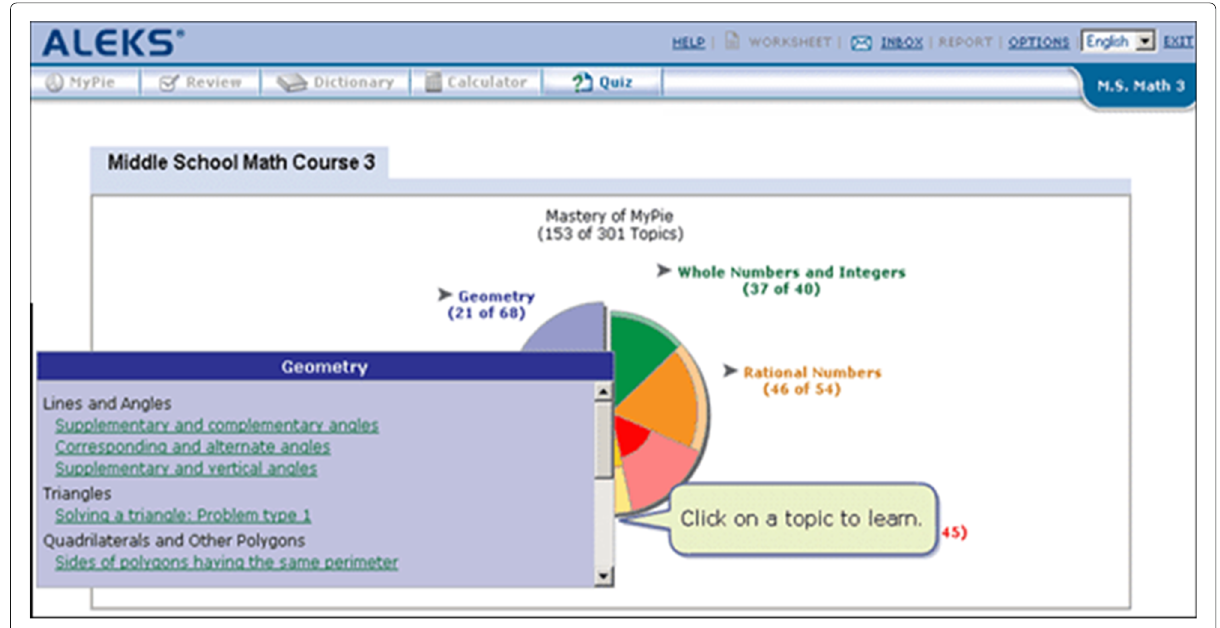
Fig. 1 ALEKS pie: adaptive availability of skills (KC’s) to